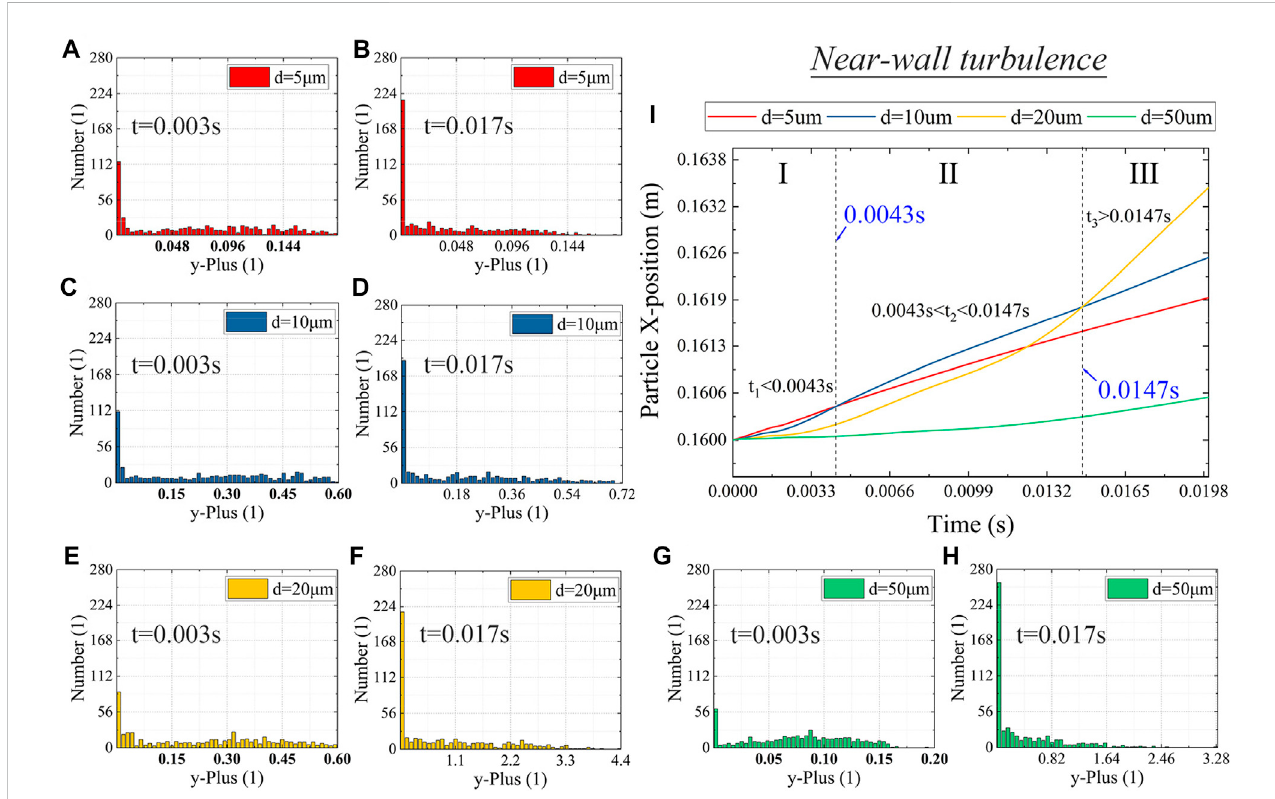
FIGURE 8 Anisotropic near-wall turbulence on particle motion at different times, where (A-H) are histograms of particle number vs. y + with a diameter of 5, 10, 20 and 50 μ m, respectively; and (I) is the particle translational distance in the X-direction vs. time.